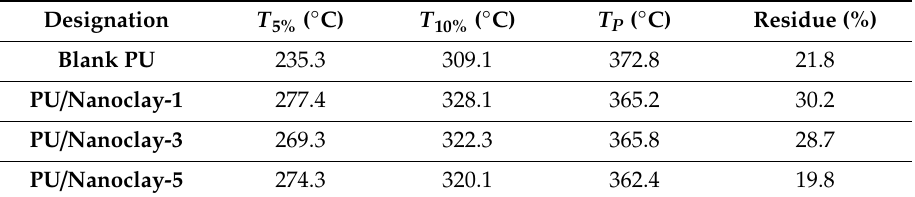
Table 1. Thermal decomposition characteristics of PU / Clay nanocomposites derived from TGA diagrams at β = 5 ◦ C /